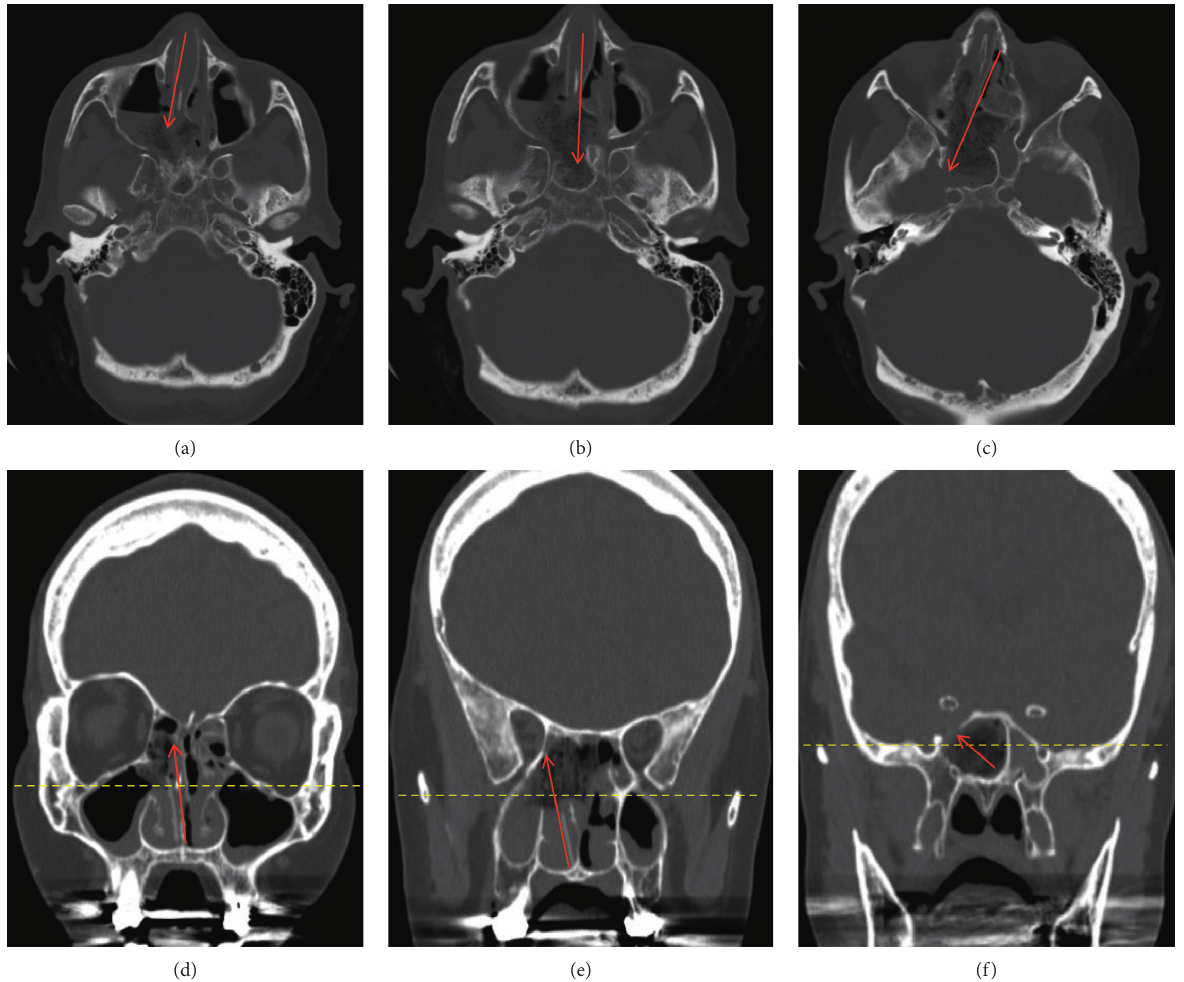
Figure 9: CT maxillofacial with sequential cuts to demonstrate the overall trajectory of an endoscopic endonasal right transpterygoid approach. (a–c) Axial views of the anterior skull base. (d–f) Coronal views of the same region. Red arrows estimate the working trajectory. Note the bony opening in the anteromedial aspect of the middle cranial fossa to expose the contents of MC in axial (c) and coronal views (f). This corresponds to the intraoperative view in Figure 4 with the internal carotid artery located superior and medial to the bony